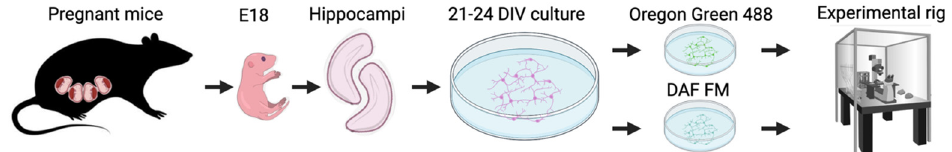
Figure 6. Time-line diagram of experimental procedures. This time-line diagram shows the pregnant mice at E18 day of embryos’ development. Embryos were dissected from uterus. The hippocampi were dissected from embryos and cut. Plated cultures grew until the 21–24 DIV, and then were incubated for 40 min with Oregon Green 488 or DAF-FM dyes. After incubation, cultures were placed in the recording chamber and moved to experimental rig.